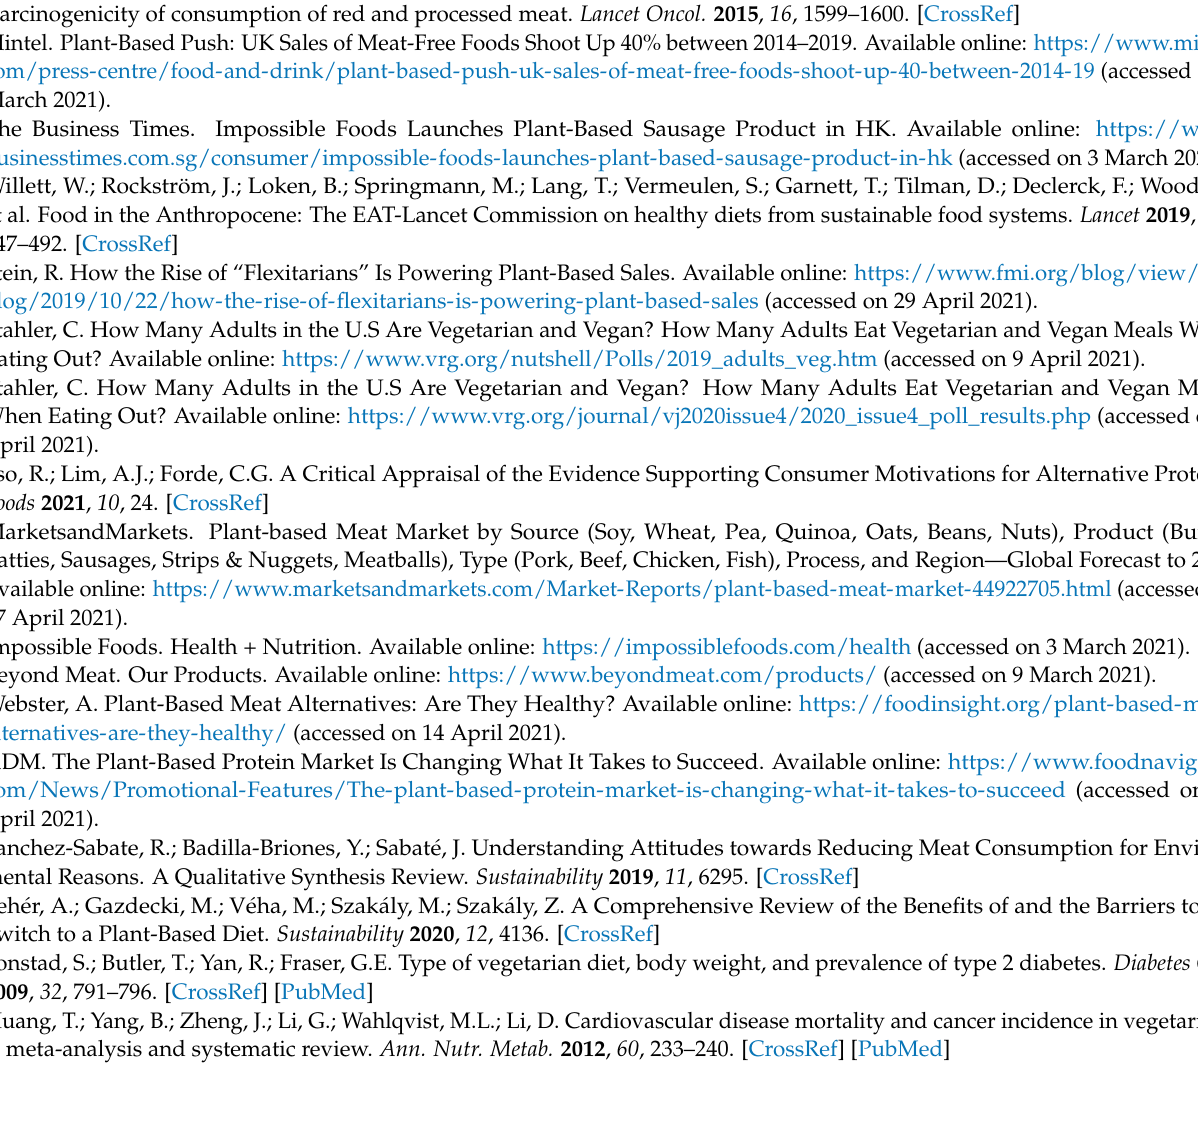
Table S3: Flexitarian-Novel (Flex-New) Diet; Table S4: Vegetarian-Traditional (Veg-Trad) Diet; Table S5: Vegetarian-Novel (Veg-New) Diet; Table S6: Vegan-Traditional (Vegan-Trad) Diet; Table S7: Vegan-Novel (Vegan-New)